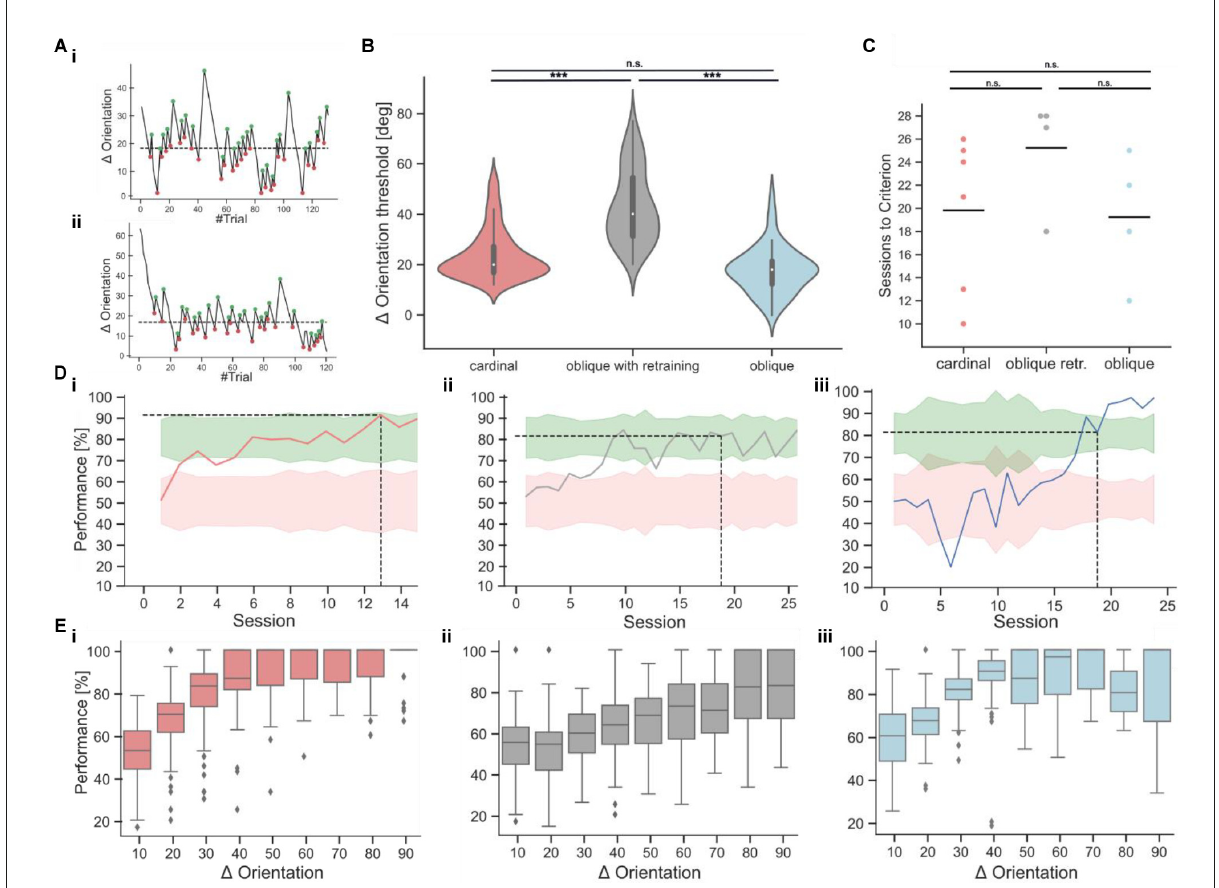
FIGURE5 Orientation discrimination with cardinal or oblique target stimuli. (Ai,Aii) Two example sessions from the staircase experiment, showing fluctuations in orientation differences over the course of each session. The turning points, used for the calculation of the threshold are indicated as green and red dots. The dashed line indicates the threshold as the average of all turning points. (B) Orientation discrimination thresholds for cardinal targets (137 sessions from six mice), oblique targets after retraining (69 sessions from four mice), and oblique targets without retraining (52 sessions from four mice). Discrimination thresholds with a cardinal target were significantly lower compared to oblique targets after retraining the same animals (Kruskal-Wallis-Test, p < 0.001). Animals that were directly trained on oblique targets, had similar discrimination thresholds as animals trained on a cardinal target (Kruskal-Wallis-Test, p = 0.62) and lower discrimination thresholds as retrained animals (Kruskal-Wallis-Test, p < 0.001). (C) Comparison of the training duration in sessions until the mice reached expert performance. The differences were not significant (Kruskal-Wallis-Test, p = 0.15). (Di–iii) Example learning curves from animals in the different task conditions, following the color code from 5C. The dashed line indicates after how many sessions the expert threshold of 80% performance was reached on two consecutive sessions. (Ei–iii) Psychometric curves derived from the staircase experiment for the cardinal (red), retraining (gray), and oblique (blue) training condition. The bin size is 10 ◦ and the x-axis indicates the upper boundary of each bin. *** p < 0.001. No significant results are indicated by “n.s.” ( p = > 0.05).